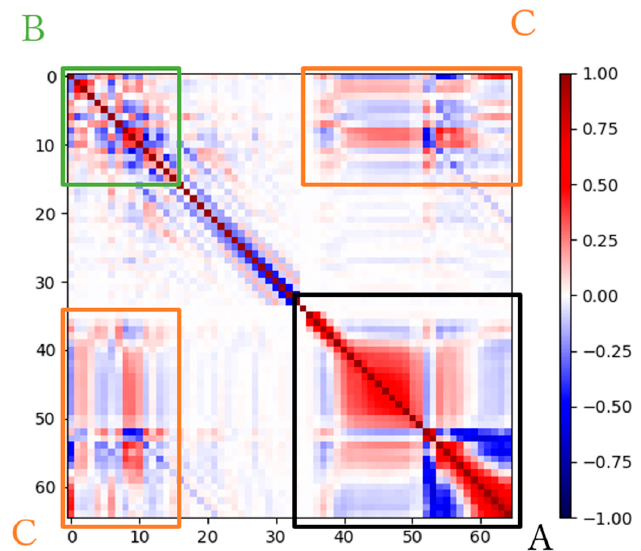
Figure 3. Heat map for the correlation coefficients among the 65 audio features.